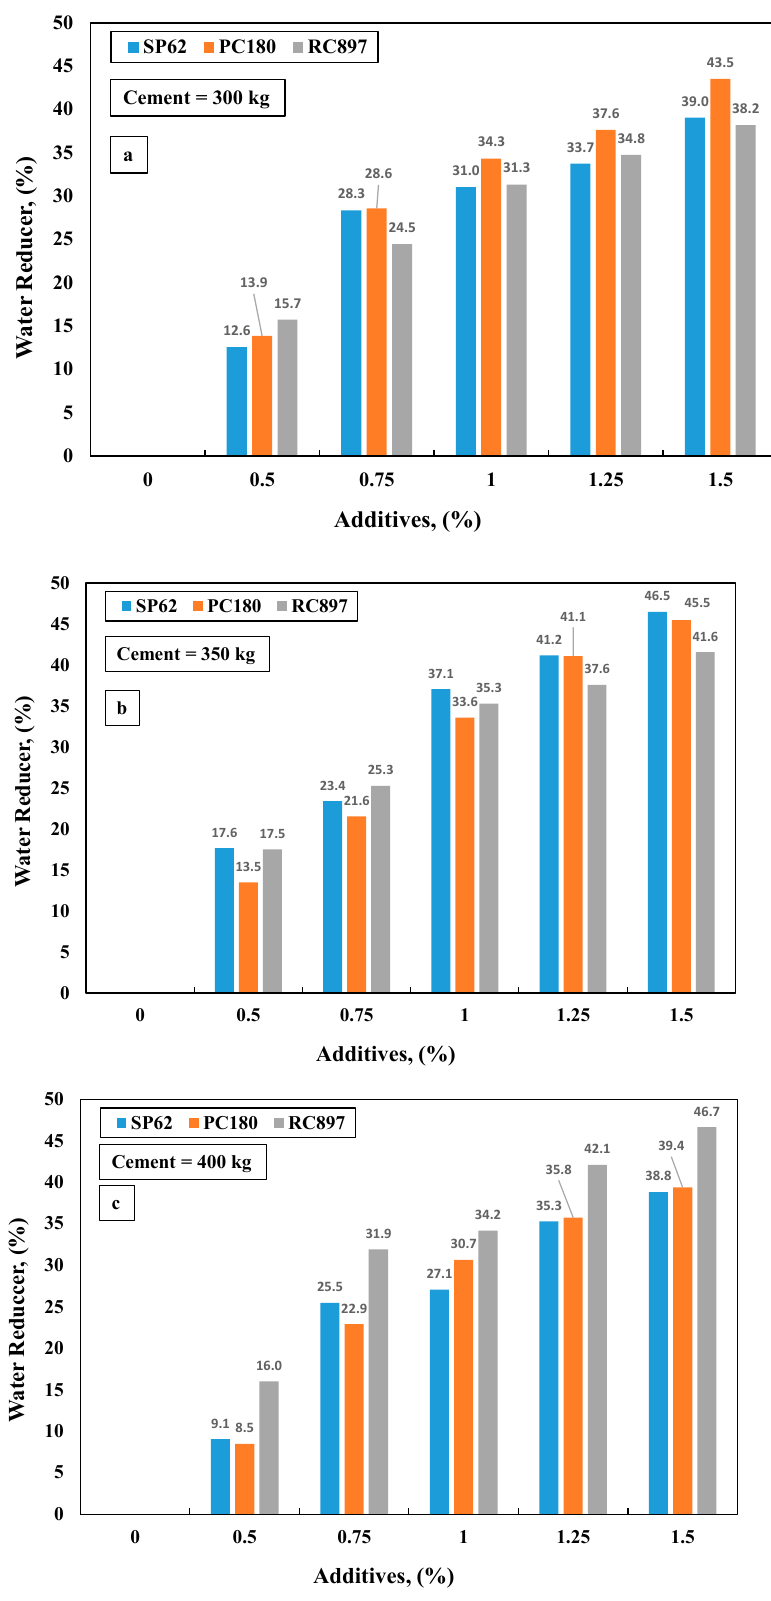
Figure 2. Percentage of water reduction caused by the addition of 3 types of additives in concrete mixes with ( a ) 300 kg, ( b ) 350 kg, and ( c ) 400 kg of cement.